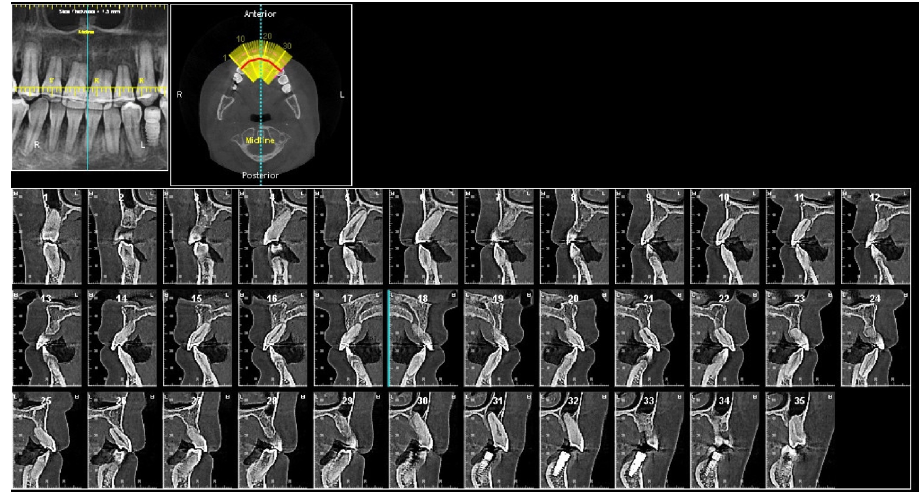
Figure 11. Posttreatment cross section images of maxillary anterior teeth. Maxillary right canine: slices #3–#7. Maxillary right lateral incisor: slices #8–#12. Maxillary right central incisor: slices #13– #17. Maxillary left central incisor: slice #18–#23. Maxillary left lateral incisor: #24–#28. Maxillary left canine: #29–#33.